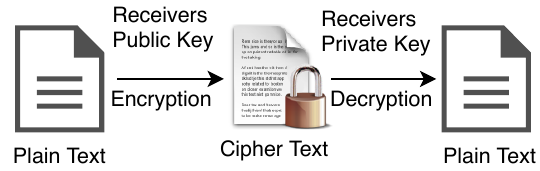
Figure 7. Asymmetric Key